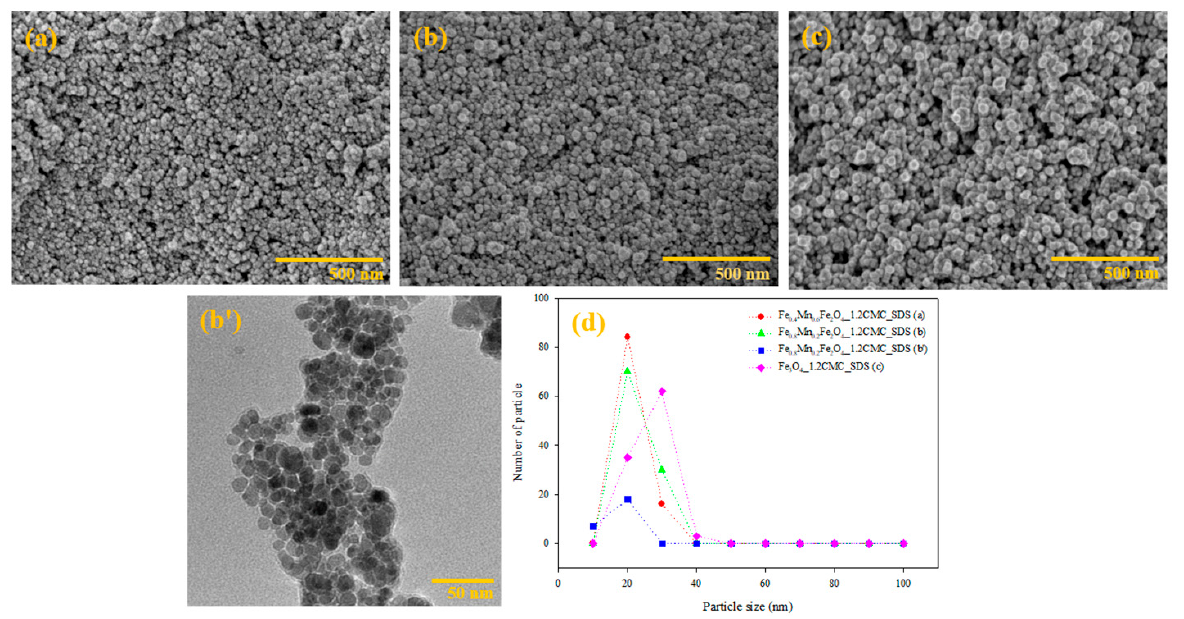
Figure 6. SEM and TEM images of the synthesized Fe (1 − x) Mn x Fe 2 O 4 _1.2CMC_SDS ferrite nanoparticles: ( a ) SEM image of Fe 0.4 Mn 0.6 Fe 2 O 4 _1.2CMC_SDS, ( b ) SEM image of Fe 0.8 Mn 0.2 Fe 2 O 4 _1.2CMC_SDS, ( b’ ) TEM image of Fe 0.8 Mn 0.2 Fe 2 O 4 _1.2CMC_SDS, ( c ) SEM image of Fe 3 O 4 _1.2CMC_SDS, and ( d ) the particle size